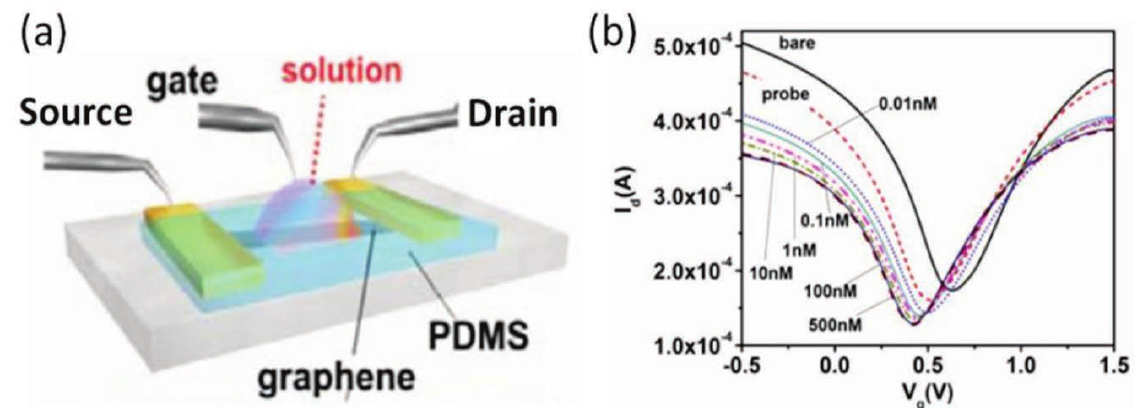
Figure 14. (a) Schematic illustration of the graphene device operated by liquid gating. (b) Transfer curves for the graphene transistors before adding DNA, after immobilization with probe DNA, and after reaction with complementary DNA molecules with the concentration ranging from 0.01 to 500 nM. Reprinted with permission from [71 ]. Copyright 2010 WILEY-VCH [